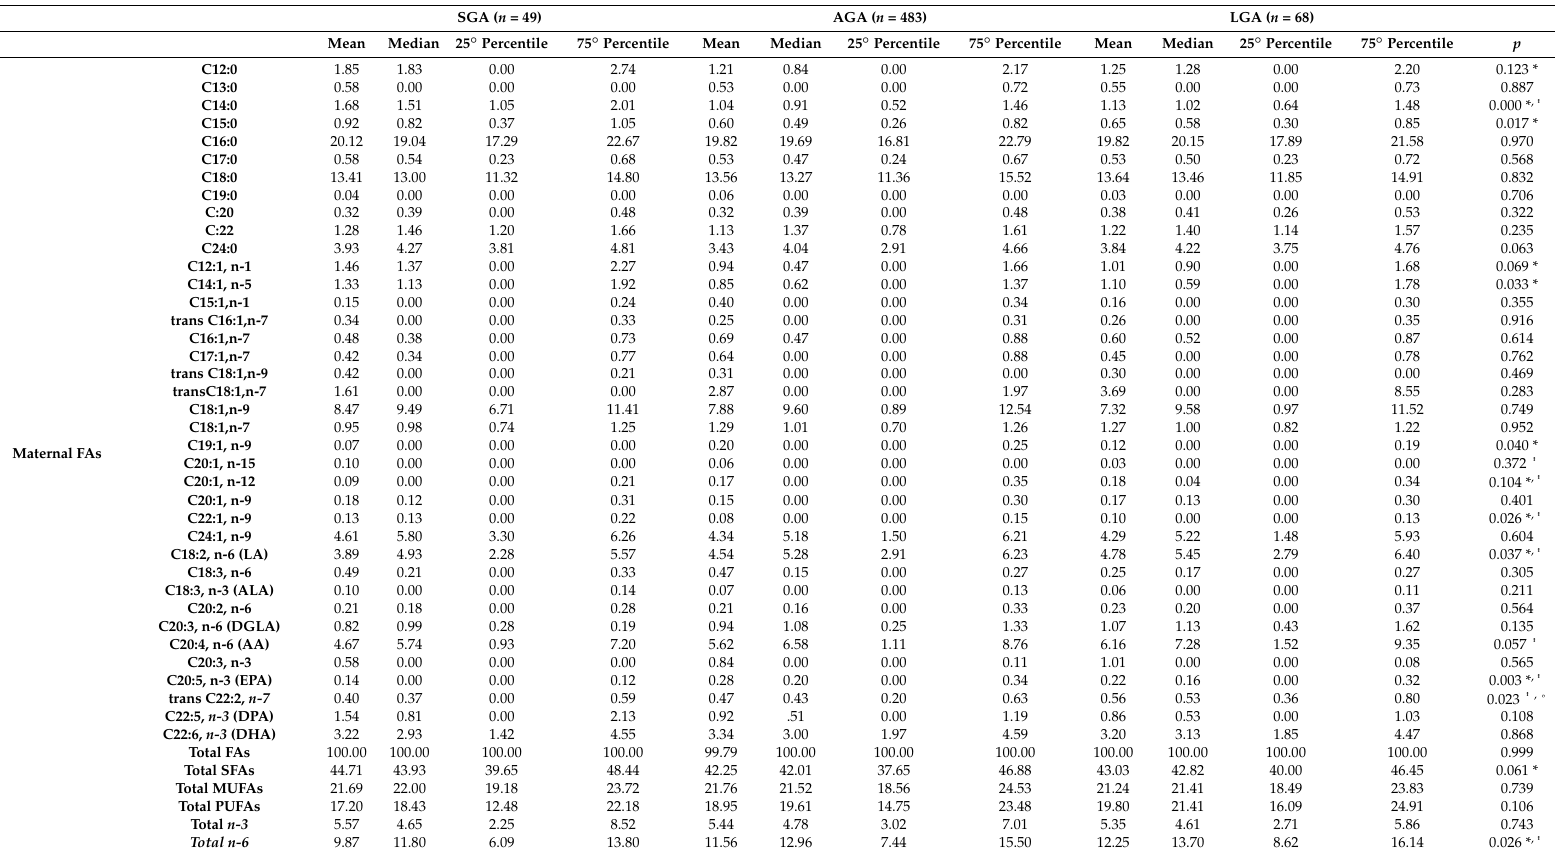
Table 3. Maternal lipid profile in Small for Gestational Age, Adequate for Gestational Age, and Large for Gestational Age